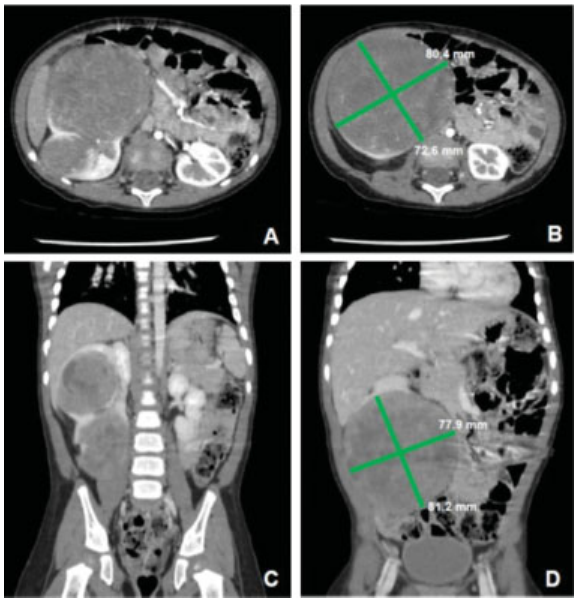
Fig. 1 Abdominal computed tomography scan with intravenous contrast. (A, B) (Superior to inferior cuts) axial view; (C, D) (posterior to anterior cuts) coronal view; 8 (cid:1) 7 cm right kidney tumor.